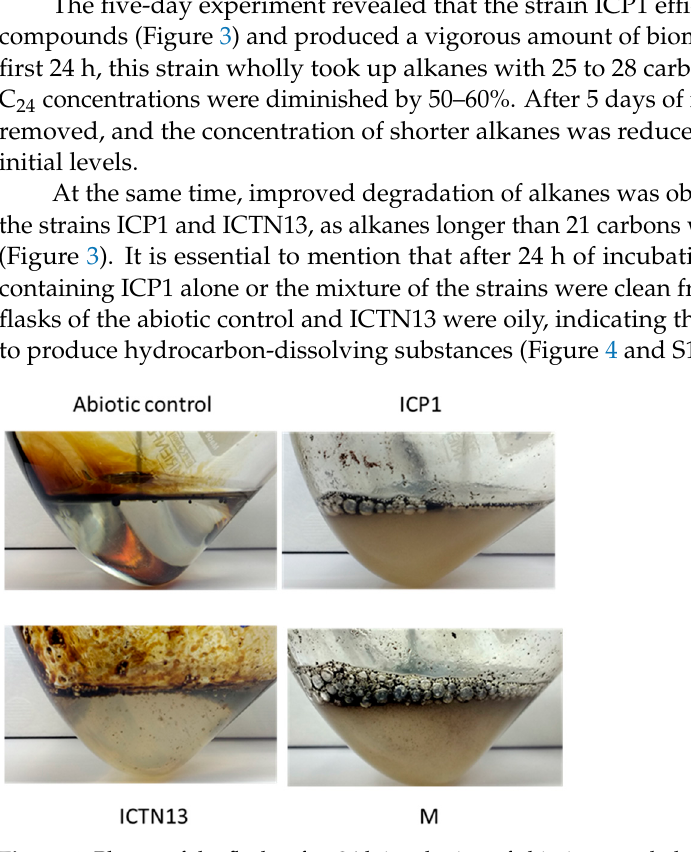
Figure 4. Photos of the fl asks after 24 h incubation of abiotic control, the A. venetianus strain ICP1, the P. oleovorans strain ICTN13, and the mixture of strains (M) in M9 minimal medium with 1% crude oil at 30 °C.